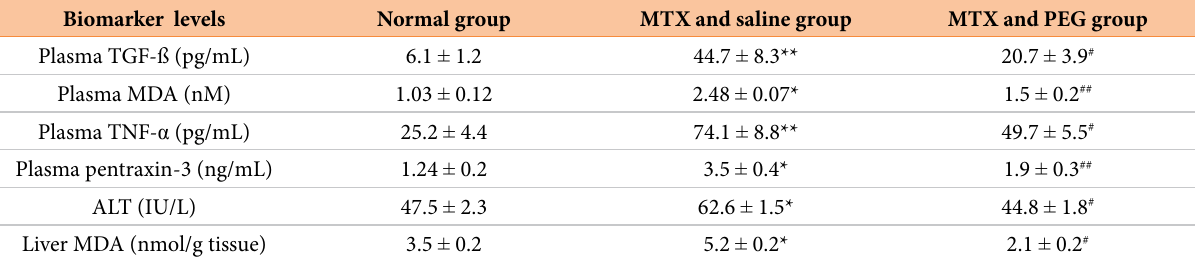
Table 1 - Comparison of biomarker levels between subject groups $